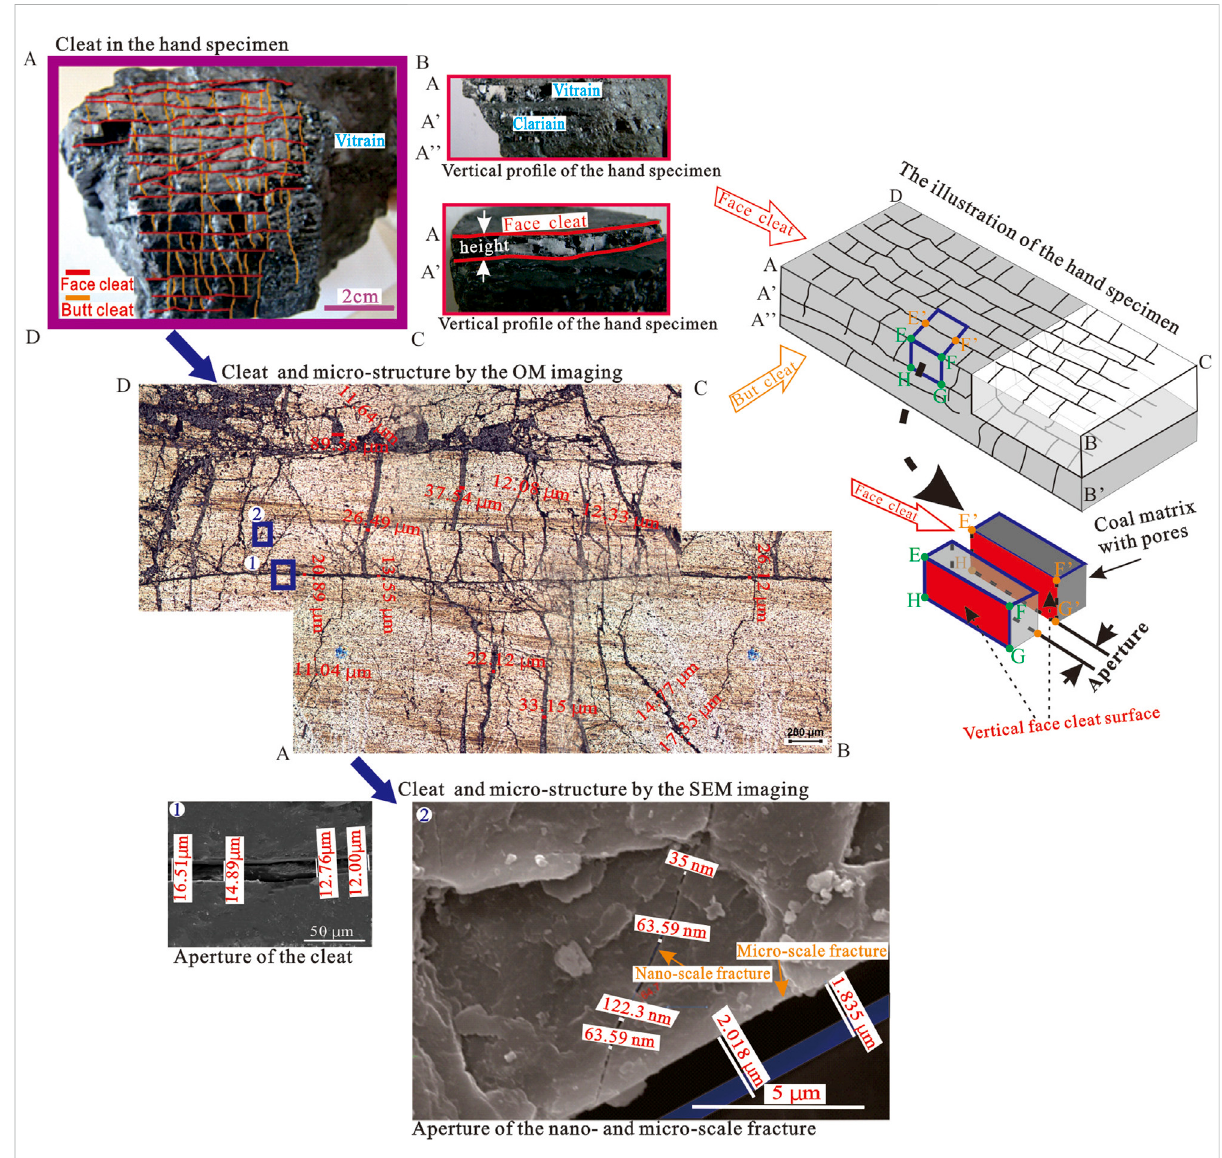
FIGURE 4 Cleats and micro-structures in coal.